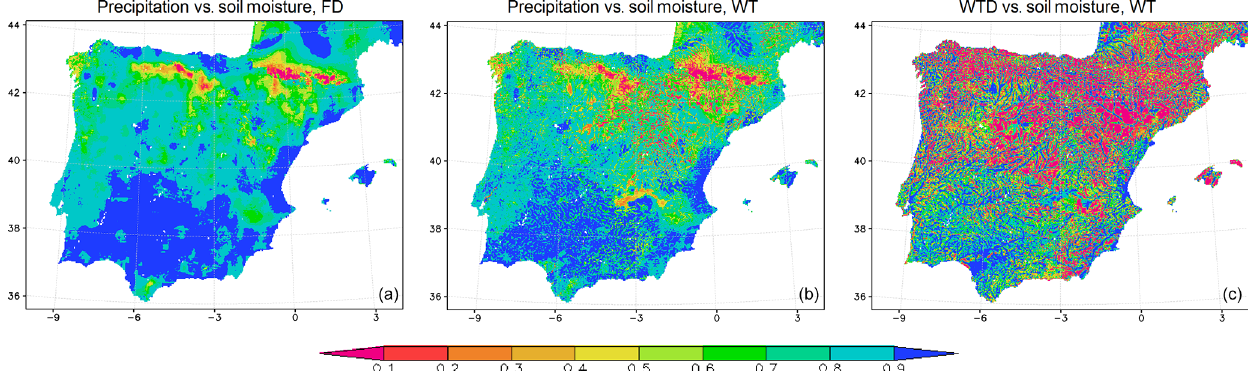
Figure 10. Correlation maps of the yearly anomaly time series for the Iberian Peninsula along the 9 complete hydrological years simulated. (a) Between precipitation and soil moisture in the free-drain (FD) run. (b) Between precipitation and soil moisture in the groundwater (WT) run. (c) Between wtd and soil moisture in the groundwater (WT)